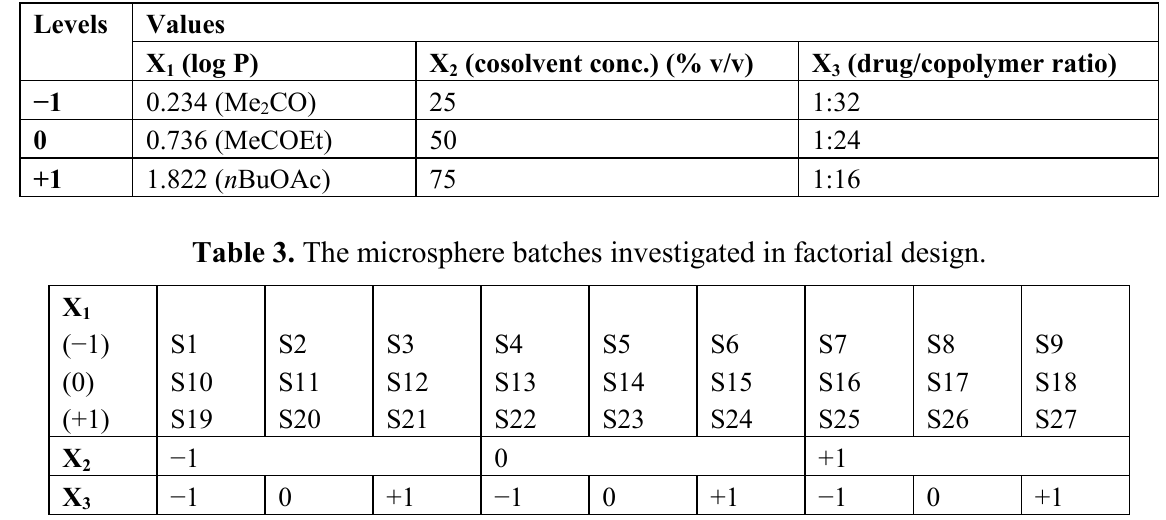
Table 2. Levels and values of the independent variables (non-randomized).